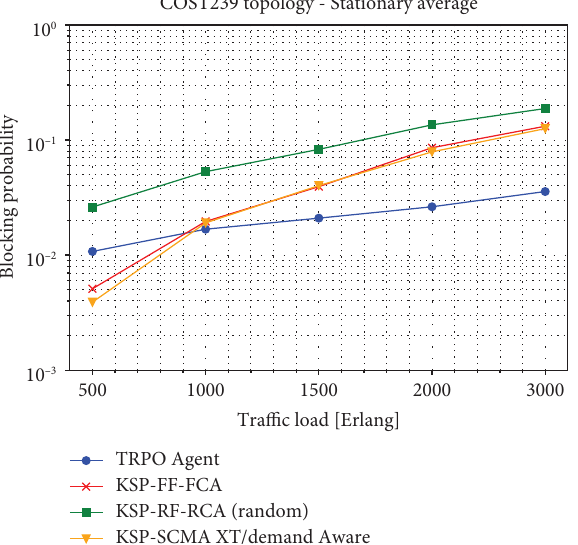
Figure 10: Blocking probability steady average of TRPO agent trained in COST239